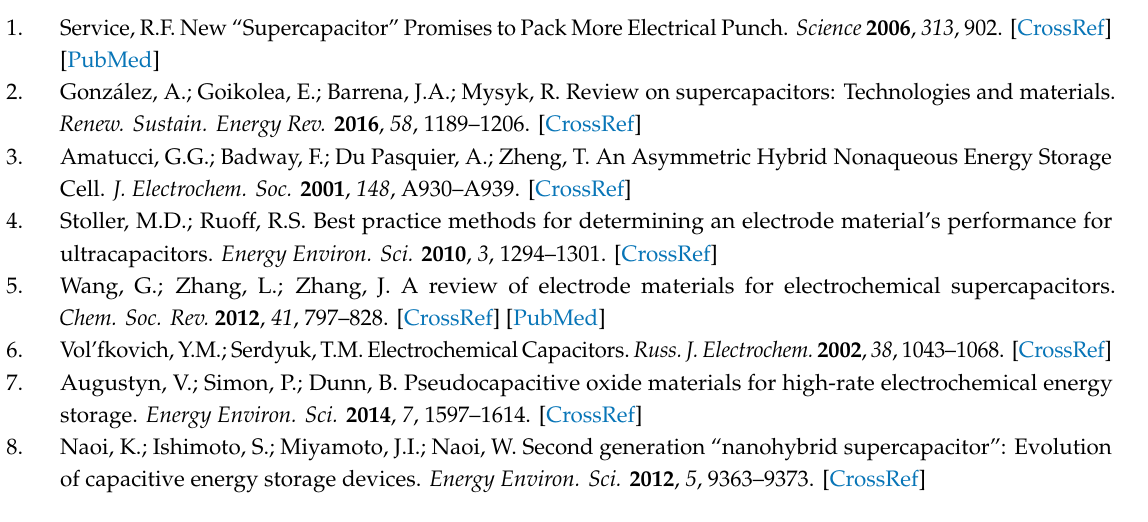
Figure S1: XPS Si2p spectra of (a) SiOC PhTES and (b) SiOC PhTES / C10g samples., Figure S2: XPS C1s spectra of (a) SiOC PhTES and (b) SiOC PhTES / C10g samples., Figure S3: (a) Deconvolution of Raman spectra of the pure graphite, (b) second-order Raman spectra of graphite, ceramic and SiOC / graphite composites, Figure S4: pictures of (a) graphite flakes, (b) graphite flakes after 2 h sonication in isopropanol, Table S1: Data obtained from the deconvolution of Raman